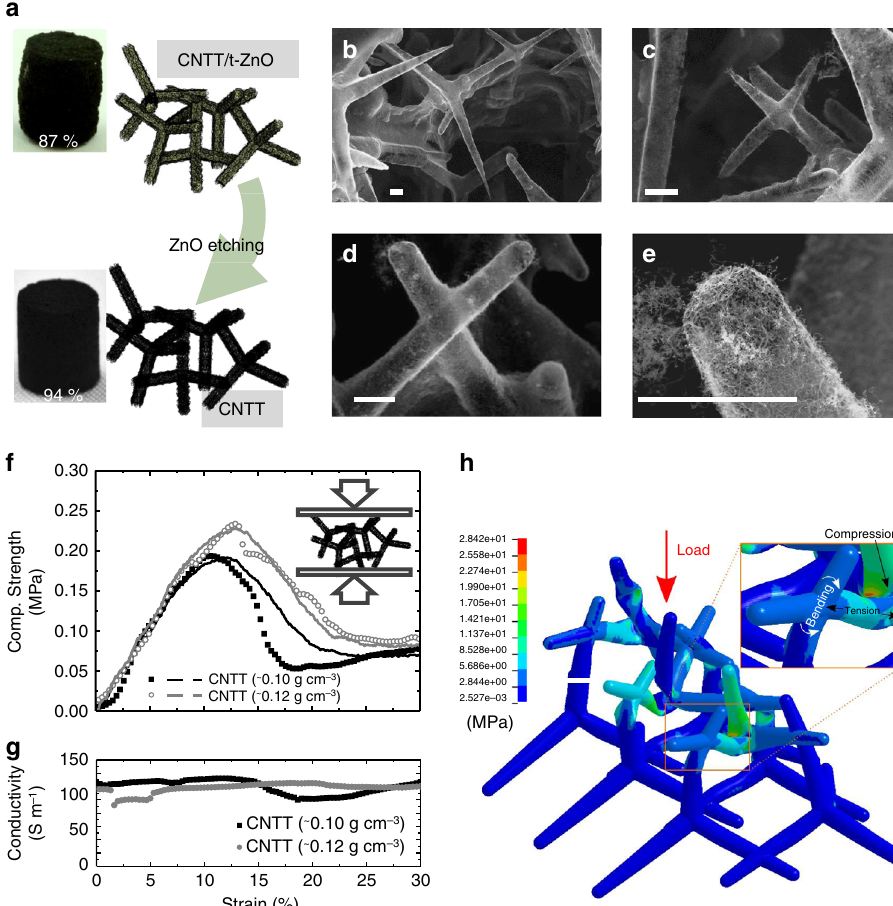
Fig. 3 Overview of the 3D CNTT structures (0.12 g cm − 3 ) obtained from CNTT/t-ZnO composites and their electrical and mechanical characteristics. a Schematic representation of the fabrication process, showing the CNTT/t-ZnO structure before and after etching with HCl (1 M in water); b – e SEM images of the resultant 3D CNTT assembly at different magni fi cations showing a hollow interconnected tubular structure consisting of self-entangled carbon nanotubes (scale bar: 5 µ m); f Compressive stress – strain curves for 3D CNTT assemblies showing a high structural strength of up to 0.24 MPa (dots represent experimental measurements, continuous line FEM simulation); g Conductivity (~130 S m − 1 ) during compression test; h FEM image showing the tensile behavior of the CNTT arms under a global compressive load, indicating that the CNTs are employed in their tensile properties, even though the structure is